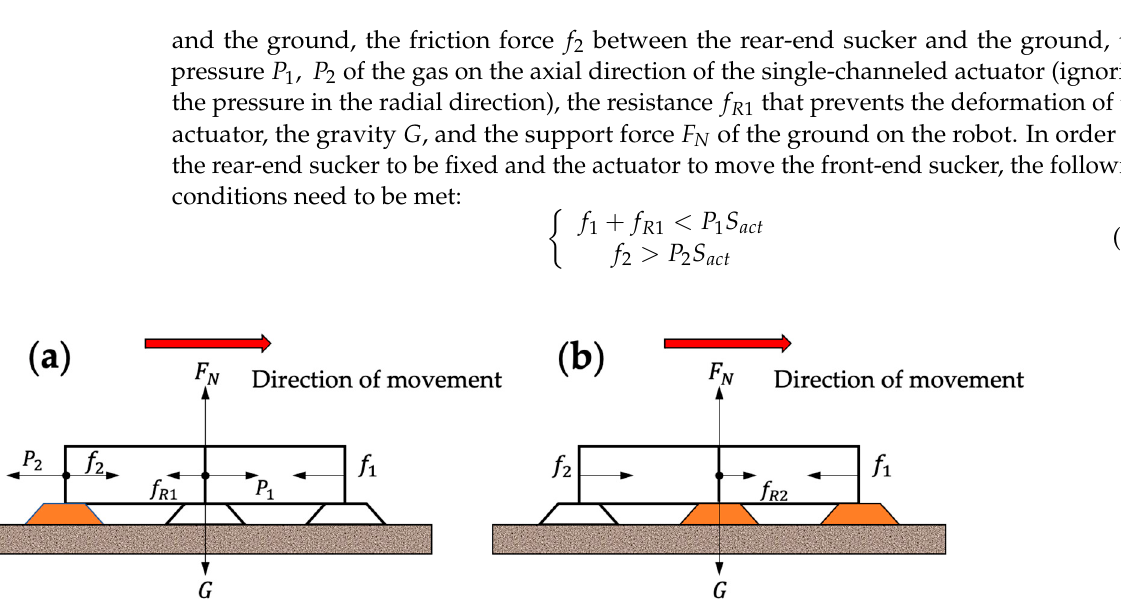
Figure 11. Force analysis of straight-line locomotion. ( a ) When the front-end and middle suckers move. ( b ) When the rear end sucker moves.